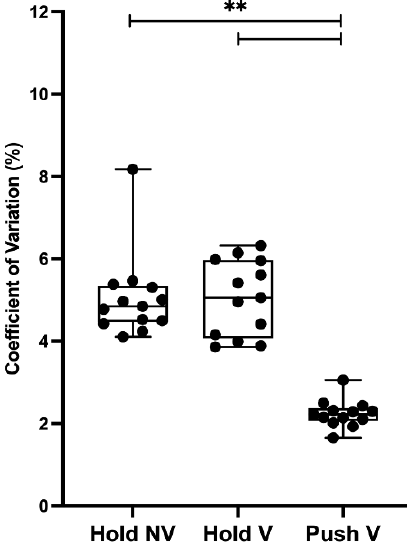
Figure 3. Coefficient of variation mean values for each condition. Abbreviations are as follows: Hold NV, hold isometric task without visual feedback (H non-visual ); Hold V, hold isometric task with visual feedback (H visual ); Push V, push isometric task with visual feedback (P visual ); ** indicates p < 0.001 .